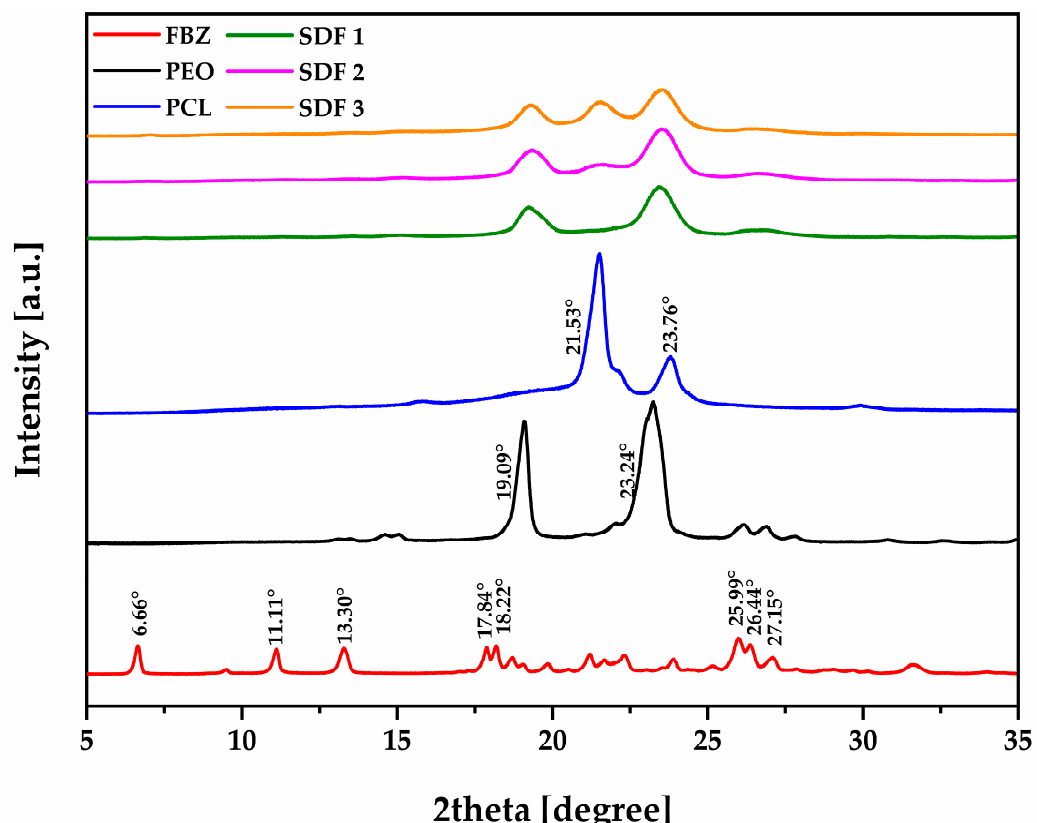
Figure 6. XRD diffraction patterns of FBZ, PEO powder, PCL powder, SDF 1, SDF 2, and SDF 3.